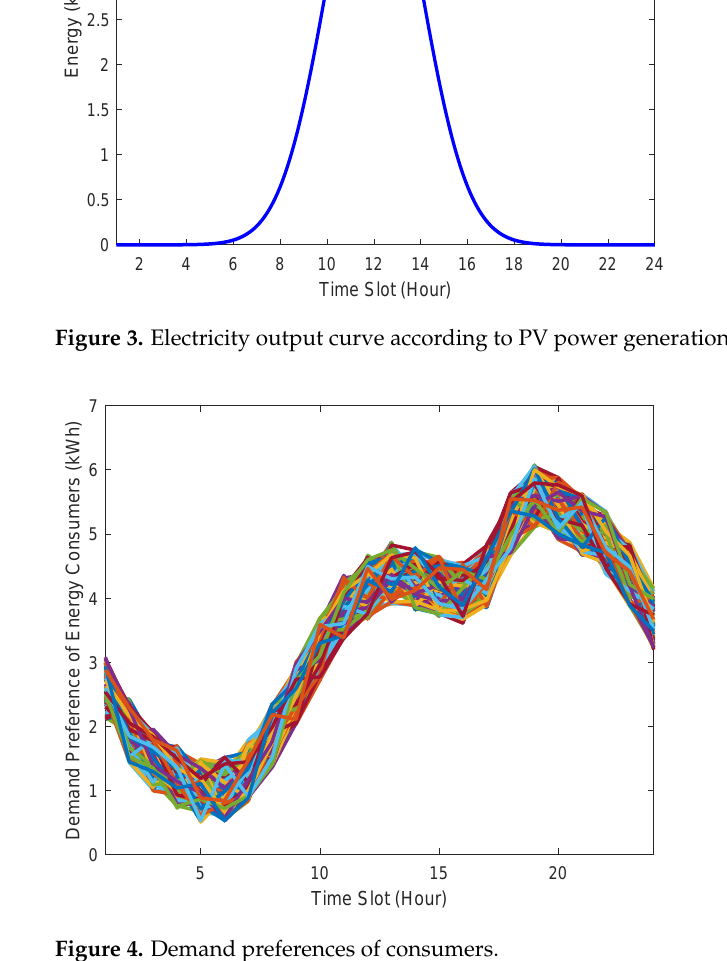
Figure 4. Demand preferences of